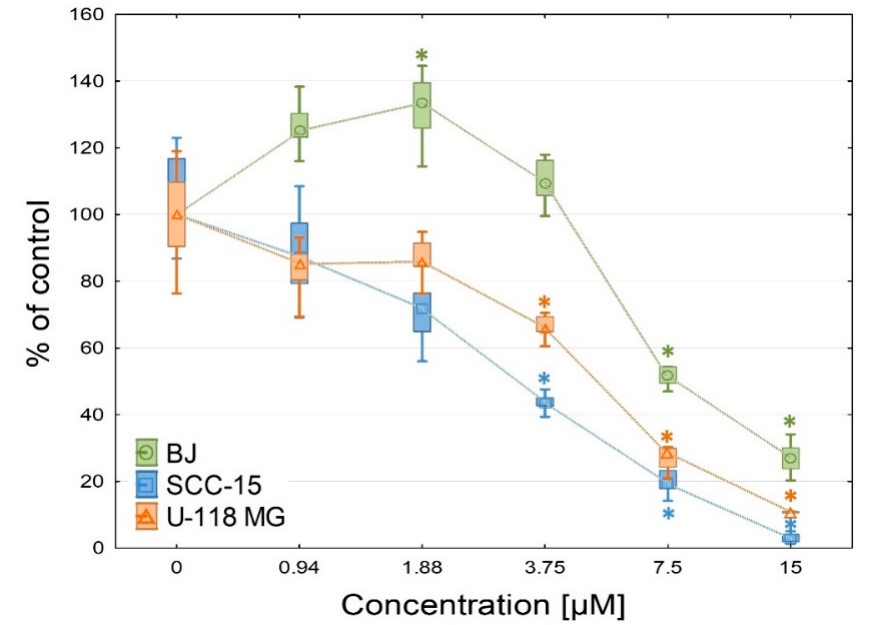
Figure 7. Influence of G3 G02N on BJ, SCC-15 and U-118 MG cell proliferation after 72 h incubation, estimated after DAPI staining. Data are presented as % of non-treated control. Results are a median of triplicates from three independent experiments. The whiskers are lower (25%) and upper (75%) quartile ranges. * indicate statistically significant differences estimated with the Kruskal ‒ Wallis test ( P < 0.05). The inhibition of cell division was particularly evident in the SCC-15 line and only slightly weaker in the case of glioblastoma cells, with IC 50 values of 3.19 and 4.48 µ M, respectively, compared to 9.28 µ M for normal human fibroblasts. Likewise, the strong inhibitory action of nimesulide after 72 h incubation against human squamous carcinoma cells (A431) was observed by Khodaie et al.